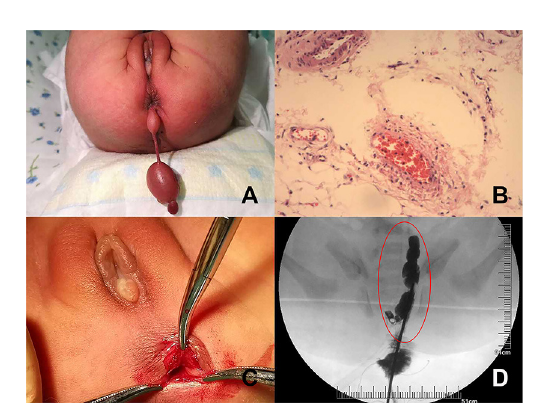
FIGURE2 (A) Gross appearance of the perineal masses at birth. (B) The histological examination results of the perineal masses show hyperplastic lymph vessels and adipose tissue that conformed to hamartomas. (C) After the mass was removed, a cavity can be seen clinging to the posterior wall of the rectum. (D) Under contrast agent, the radiography shows an irregular cystic mass located in the presacral